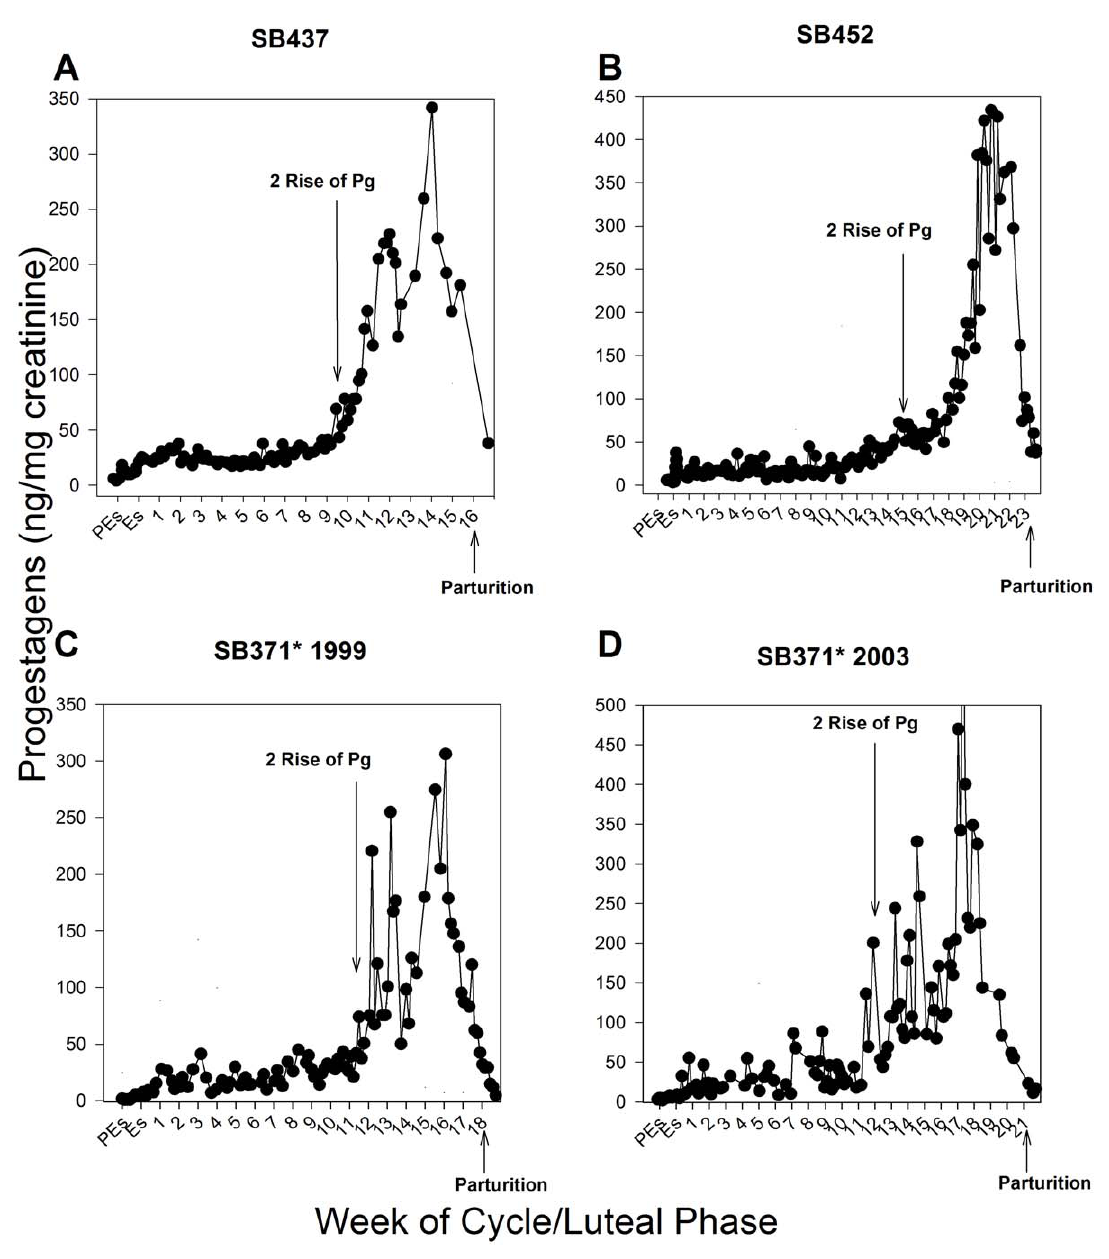
Figure 3. Urinary progestagens in representative pregnancies carried to term in female giant pandas. Black circles represent urinary progestagen concentrations; Pg=Progestagen; PEs=Proestrus; Es=Estrus; Numerical numbers=weeks of the luteal phase. Variations in the x and y axes exist to accommodate variable concentrations and durations. *Because urinary progestagen concentrations for SB371 were analyzed using a different antibody, caution must be taken when directly comparing progestagen data between SB371 and the other animals. However, the same trends were observed in the relationship between active ceruloplasmin and progestagens in urine using both antibodies.